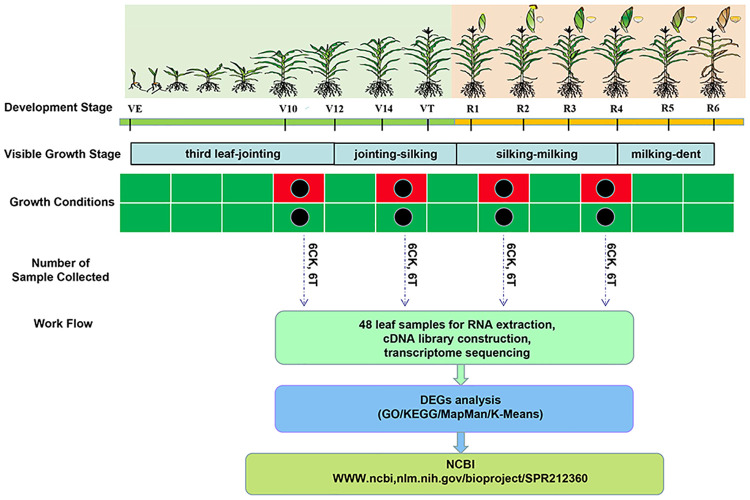
Schematic representation of the leaf transcriptome sequencing experiment under control and drought stress treatment in ND476 and ZX978 maize hybrid cultivars from vegetative to reproductive growth stages.Black dots show the time of leaf sample collection after 12 days of treatment exposure.